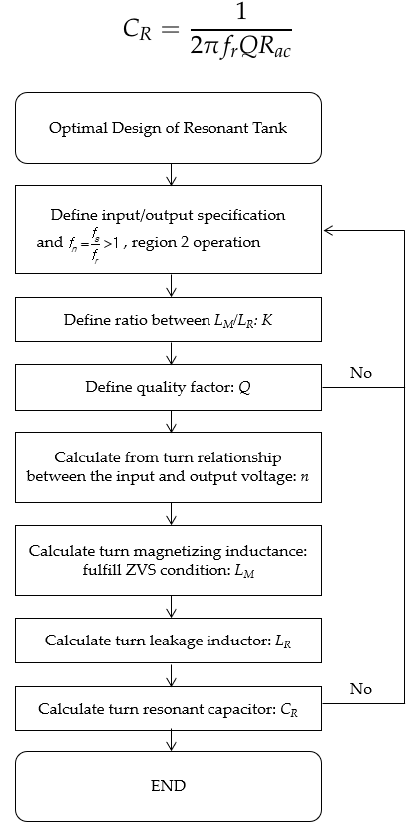
Figure 8. Flowchart for optimal design of inductor–inductor–capacitor (LLC) resonance tank.